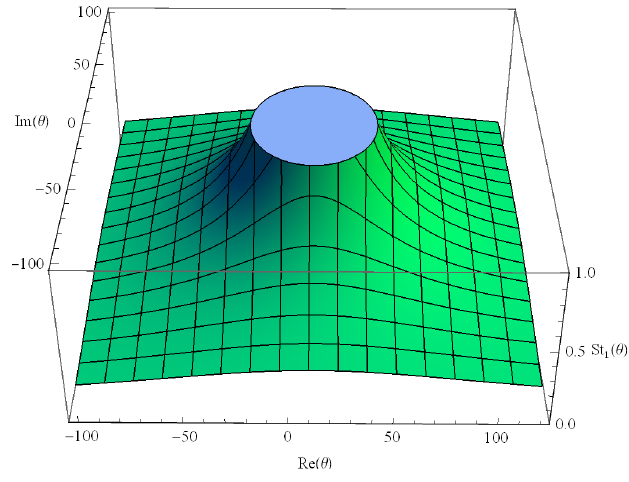
Figure 2. Stability region of z = 1.